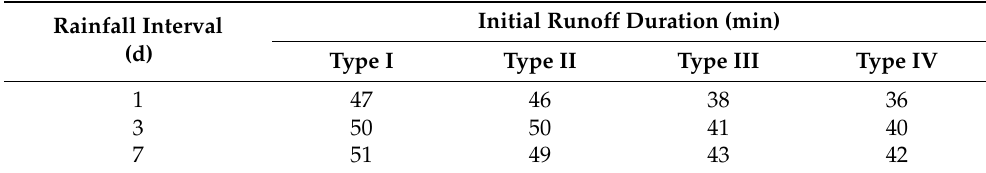
Table 4. Initial runoff time of each permeable pavement under different rainfall